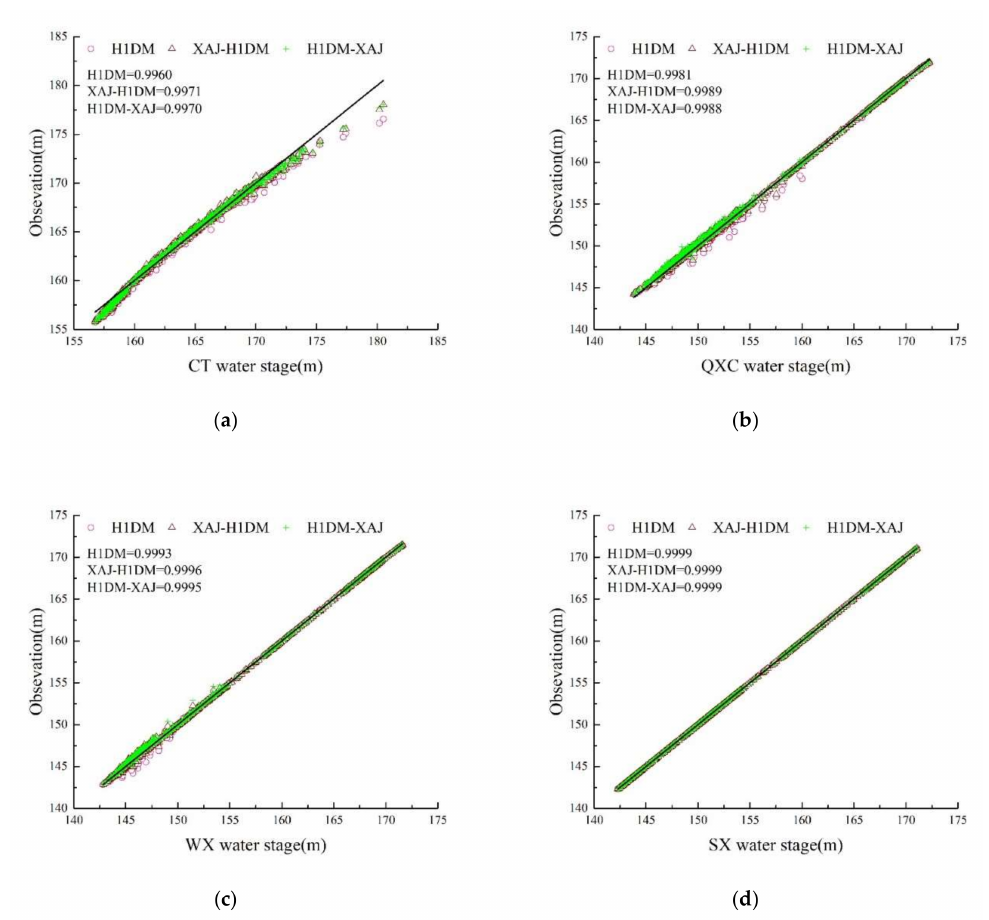
Figure 12. Water level scatter diagram and R 2 of three models in CT ( a ), QXC ( b ), WX ( c ), SX ( d ) for all